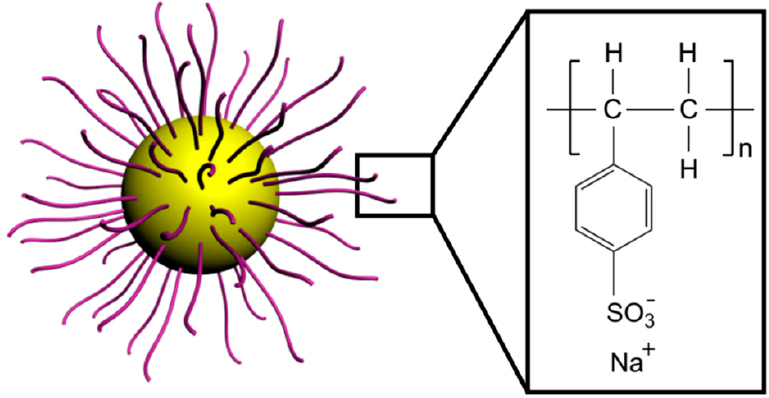
Figure 1. Schematic illustration of poly (sodium p -styrenesulfonate) (PS@PSS) structure.